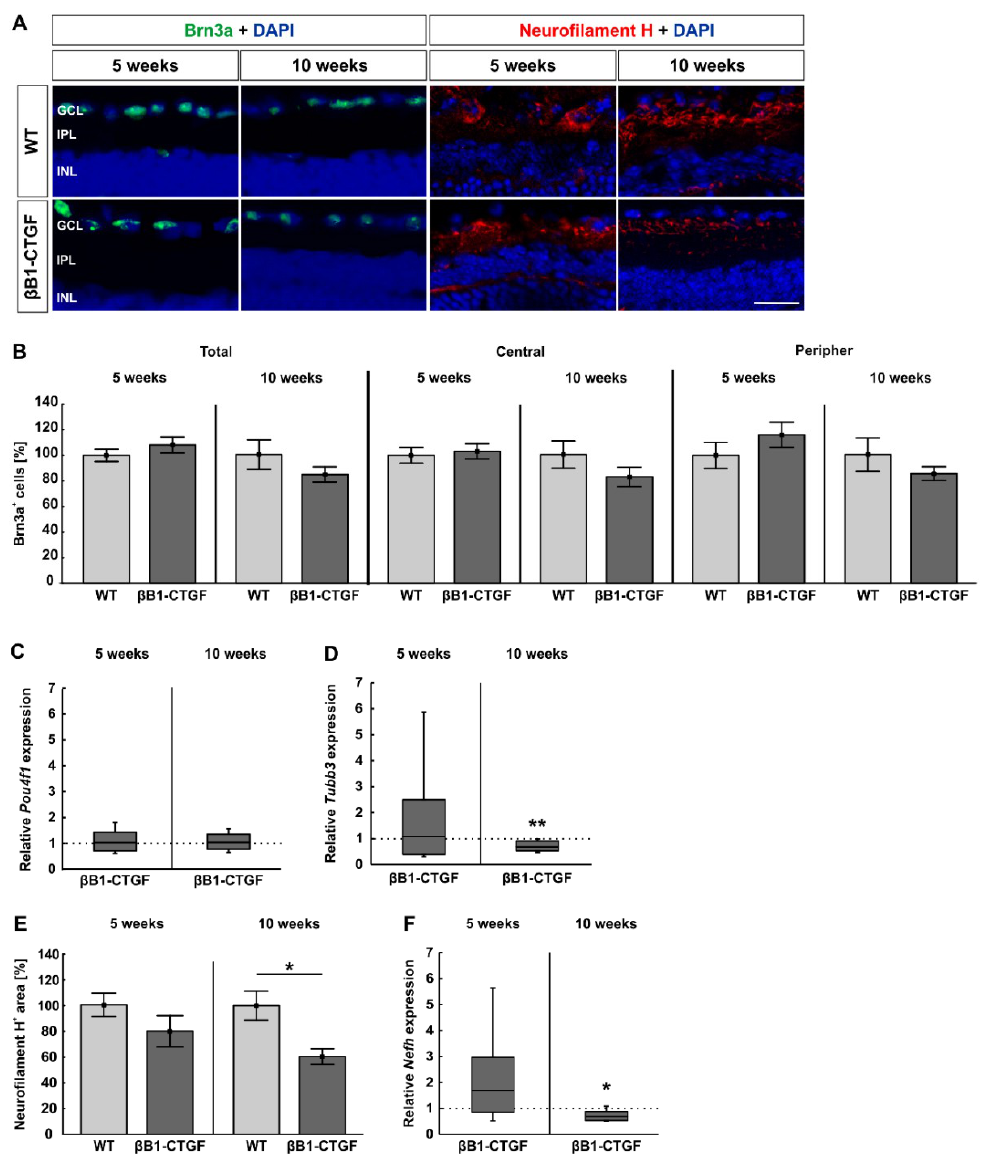
Figure 1. Loss of neurofilament H. ( A ) Retinae were stained with antibodies against Brn-3a (green) and neurofilament H (red) at 5 and 10 weeks (n = 5–8/group). Cell nuclei were visualized with 4′,6 diamidino-2-phenylindole (DAPI) (blue). ( B ) The number of Brn3a + cells remained unaltered in βB1- CTGF retinae in comparison to wildtype (WT) at 5 and 10 weeks of age in the total as well as in the central and peripheral retina. ( C ) RT-qPCR analyses were performed regarding the mRNA expression levels of the retinal ganglion cell (RGC) marker Pou4f1 at both ages (n = 5–7/group). In accordance with the immunohistological results, no alterations in Pou4f1 expression levels were noted in β B1-CTGF animals at the age of 5 and 10 weeks compared to in WT. ( D ) RT-qPCR analyses of Tubb3 were performed in 5- and 10-week-old β B1-CTGF and WT mice (n = 5/group). At 5 weeks, no changes were seen in Tubb3 mRNA expression levels. In contrast, a significant downregulation of Tubb3 mRNA was revealed in transgenic mice at 10 weeks of age ( p = 0.09). ( E ) At 5 weeks, the staining area of neurofilament H remained unchanged in transgenic and WT animals. In contrast, a significant decrease in the neurofilament H + area was detected in β B1-CTGF mice ( p = 0.01). ( F ) The mRNA levels of Nefh (n = 5/group) were not altered in 5-week-old transgenic mice. However, a significant downregulation of Nefh mRNA levels was observed in β B1-CTGF mice at 10 weeks ( p = 0.02). Abbreviations: GCL = ganglion cell layer, IPL = inner plexiform layer, INL = inner nuclear layer. Values are mean ± SEM for immunohistology and median ± quartile + maximum/minimum for RT-qPCR. The dotted lines in C, D, and F represent the relative expression levels of the WT group. Scale bar: 20 µ m. * p < 0.05, ** p < 0.01.